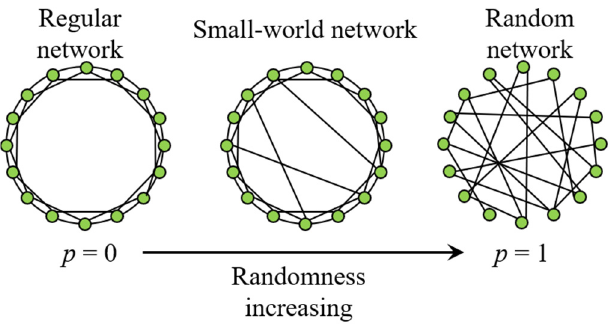
Figure 3. WS small world network model structure.